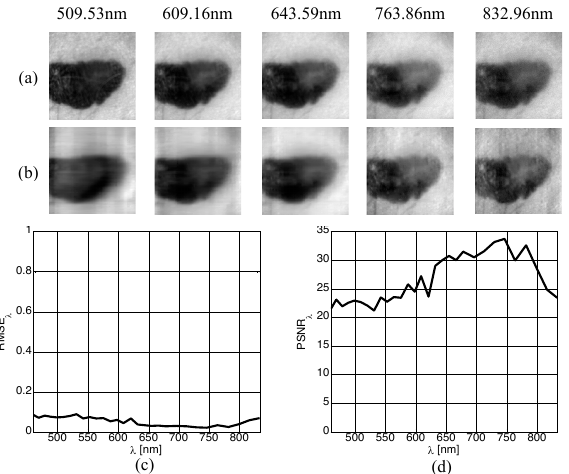
Figure 8. Five out of 30 monochromatic “Skin Tissue” images extracted from the spectral cubes at wavelengths 509.53nm, 609.16nm, 643.59nm, 763.86nm and 832.96nm: (a) reference measured with the VTT spectral imager; (b) reconstructed monochromatic images from the simulation. (c) RMSE λ and (d) PSNR λ values as functions of band number for the monochromatic images.